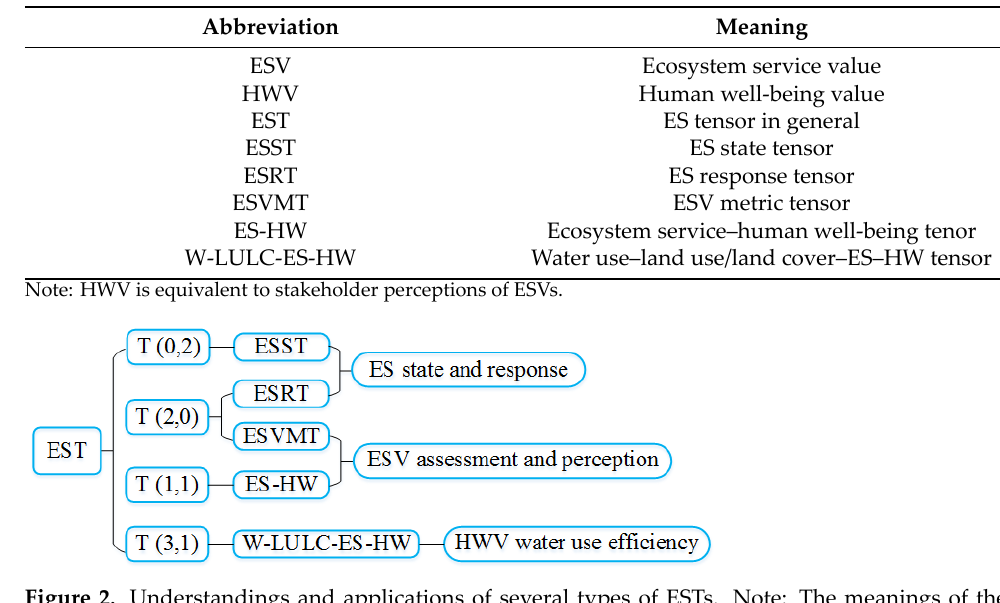
Table 1. The meaning of abbreviations in this article.